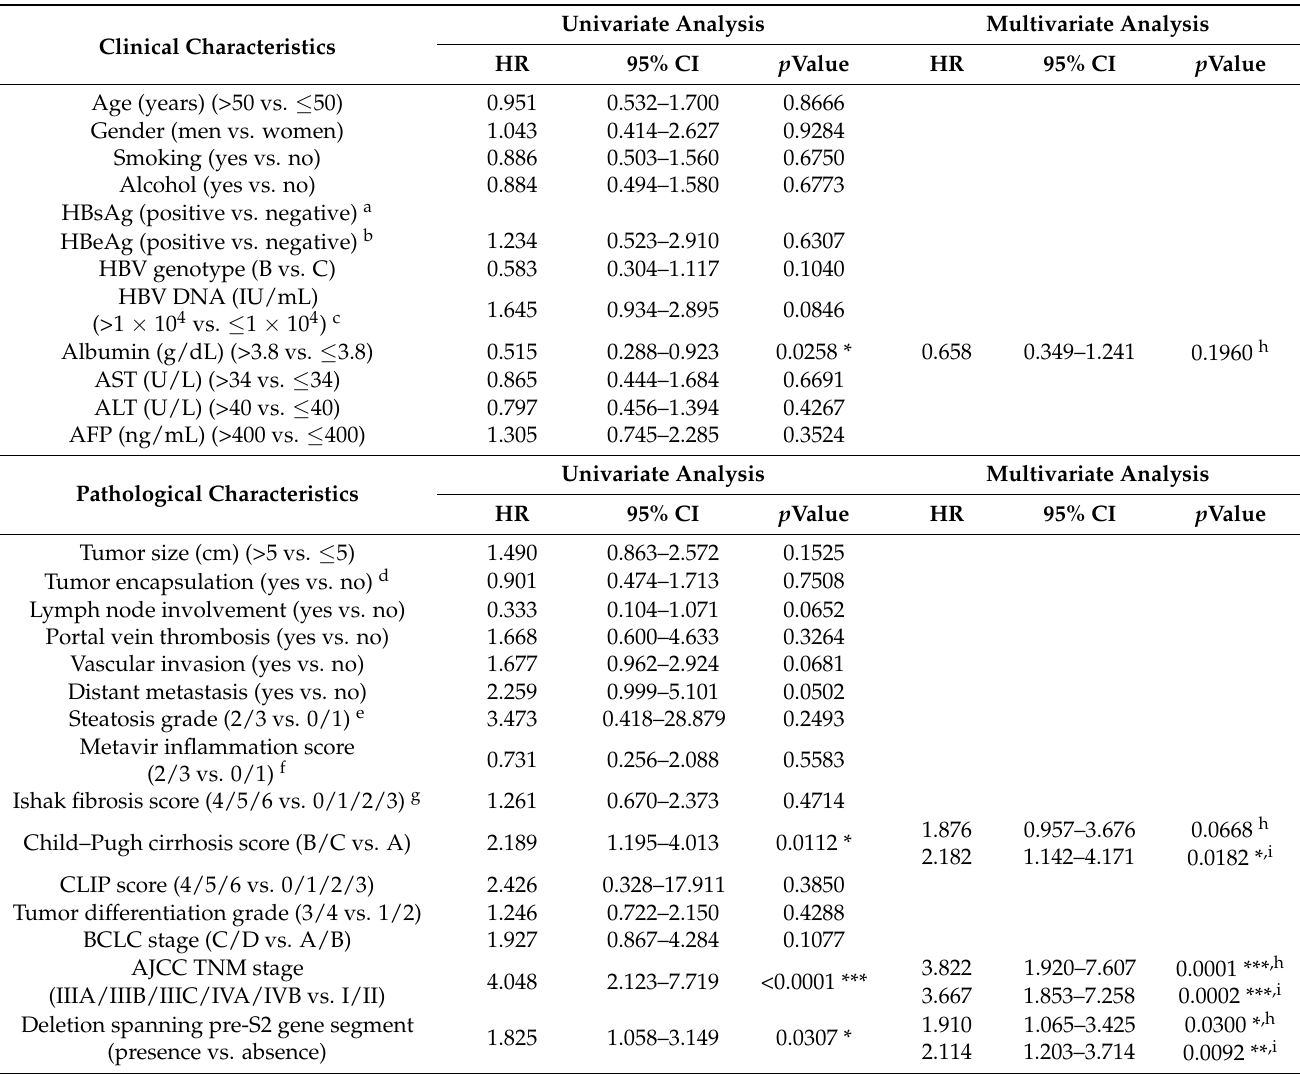
Table 3. Univariate and multivariate recurrence-free survival analyses of 75 HBV-related HCC